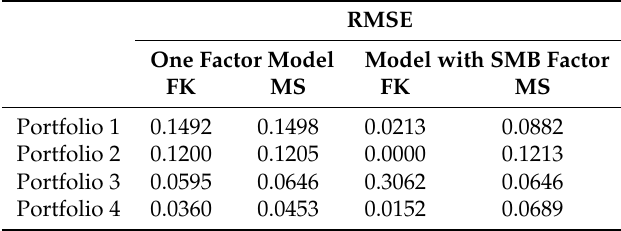
Table 4. RMSE of different estimation.